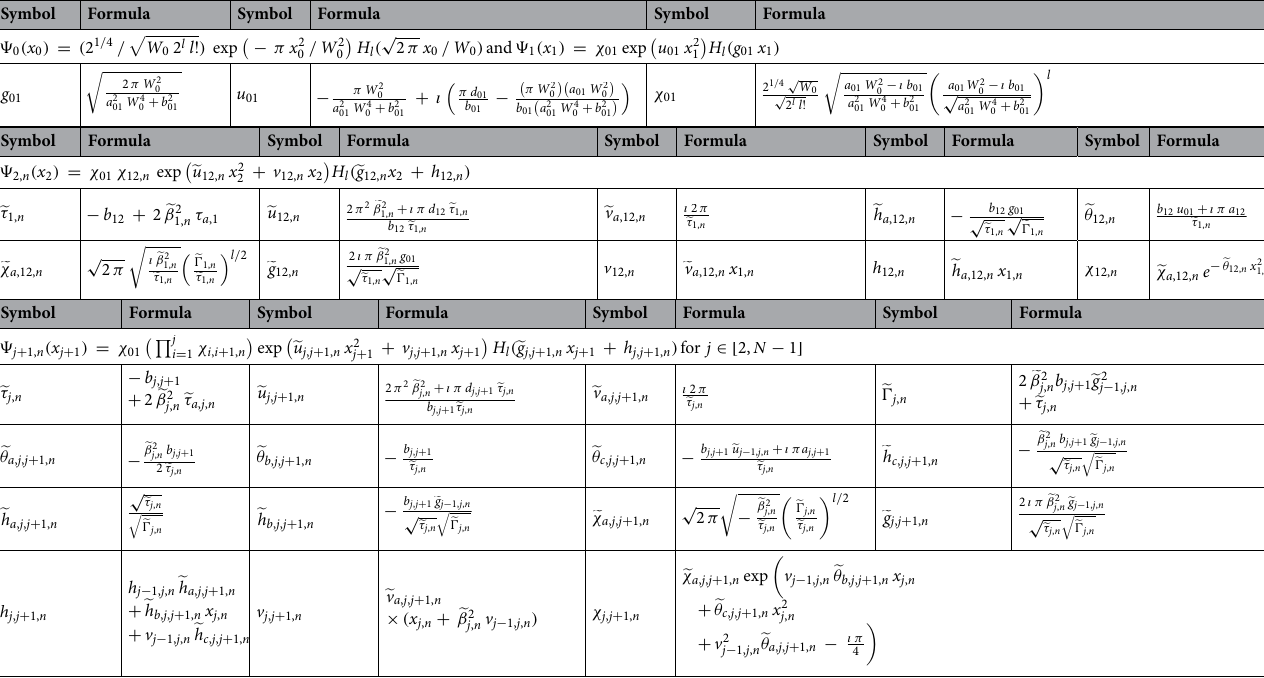
Table 3. Iteration parameters for FPI modeling of MPD with the kernel K 0 sources ( b j , j 1 �= +